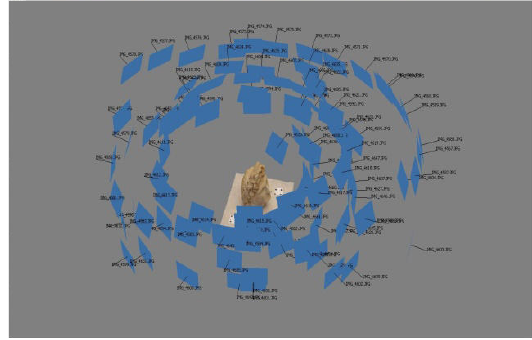
Figure 5. Dataset pose reconstruction of Alexander the Great head